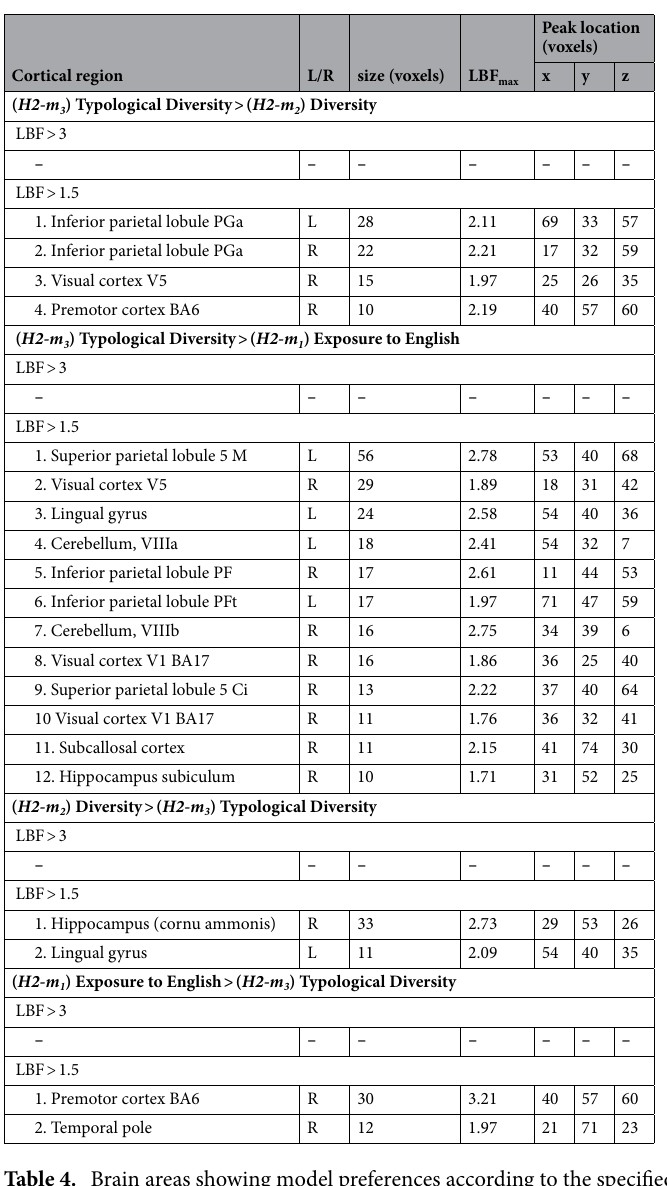
Table 4. Brain areas showing model preferences according to the specified LBF thresholds (and with clusters consisting of at least 10 voxels, ordered by size). The x, y and z coordinates are in the age-appropriate pediatric MNI NIHPD space 41 , the regions were labelled according to Harvard–Oxford Cortical and Subcortical Structural Atlases, Jülich Histological Atlas and Cerebellar Atlas (all implemented within FSLeyes, part of FSL, after non-linearly transforming the atlases to the pediatric